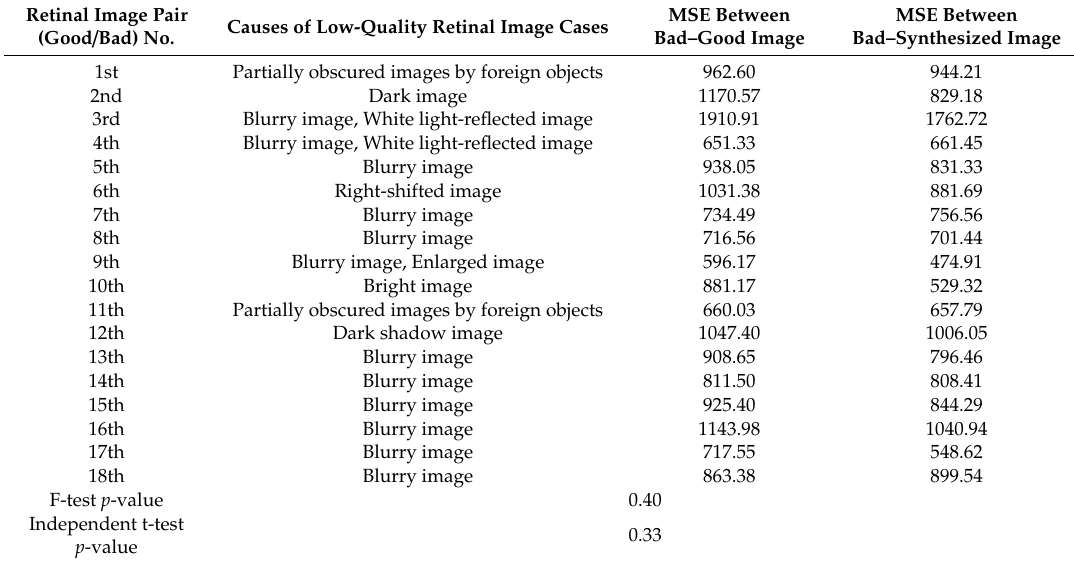
Table 3. Comparative analysis from mean-square error